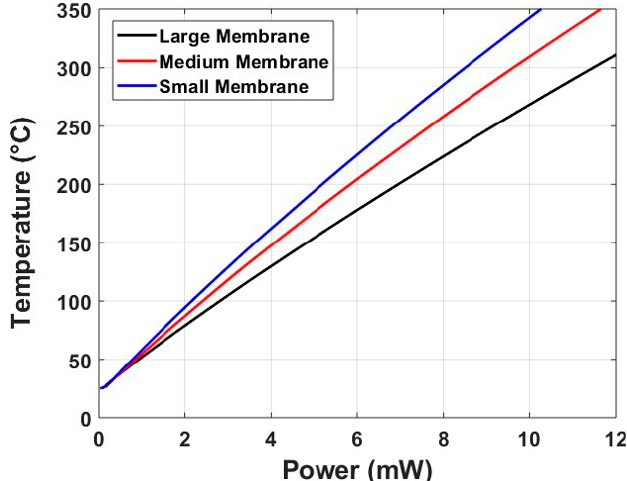
Figure 3. Power-temperature relation for the three flow sensors under test. Devices with smaller membrane require less input power to reach the same